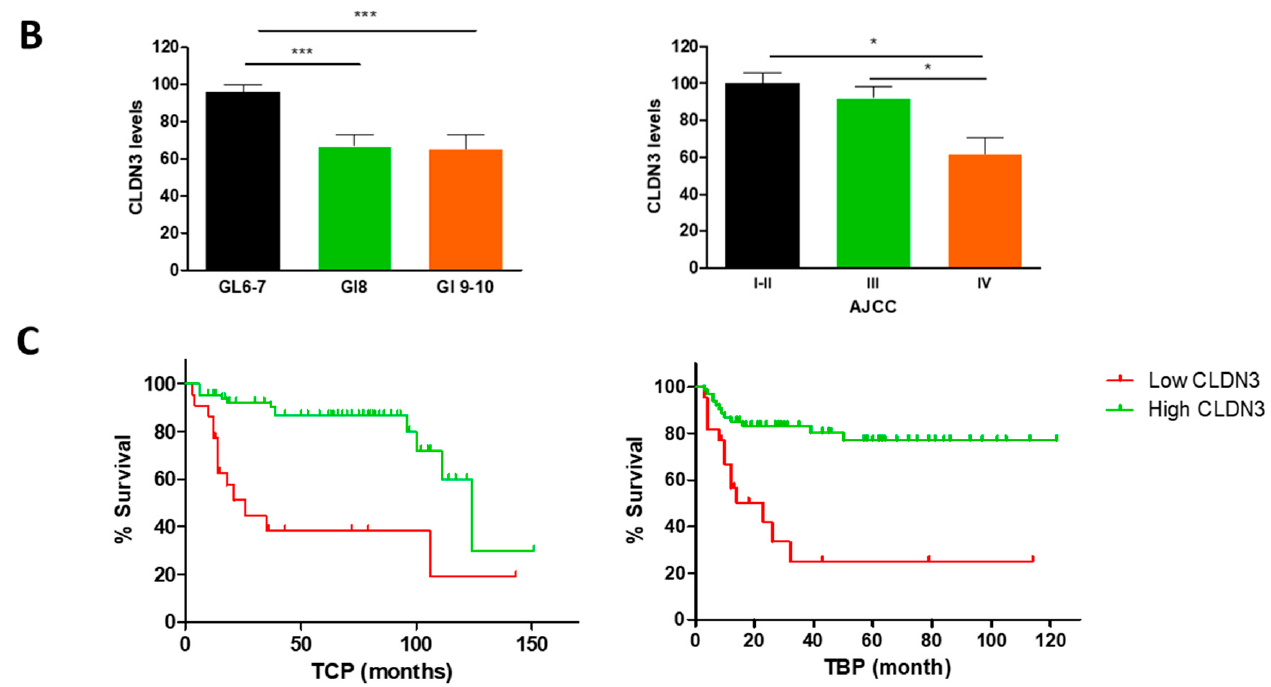
Figure 6. Analysis of CLDN3 expression in normal prostate and prostate cancer samples. ( A ) Micrographs from benign prostatic hyperplasia (BPH), hormone sensitive (HS) and resistant (HR) prostate cancers (PT) (200 × ). Immunolocalization of CLDN3 (brown staining). The signals for CLDN3 in BPH and HS were intense. In turn, most HR tumors cells showed an evident loss of the signal for CLDN3. The graph shows CLDN3 expression in BPH, HS, and HR prostate tumors measured by immunohistochemistry. ( B ). Analysis of the relationship between CLDN3 levels with Gleason score and AJCC group staging at diagnosis. ( C ) Clinical progression-free survival (TCP) and biochemical progression-free survival (TBP) of patients showing low (red line) or high expression (green line) of CLDN3. * p < 0.05; *** p <